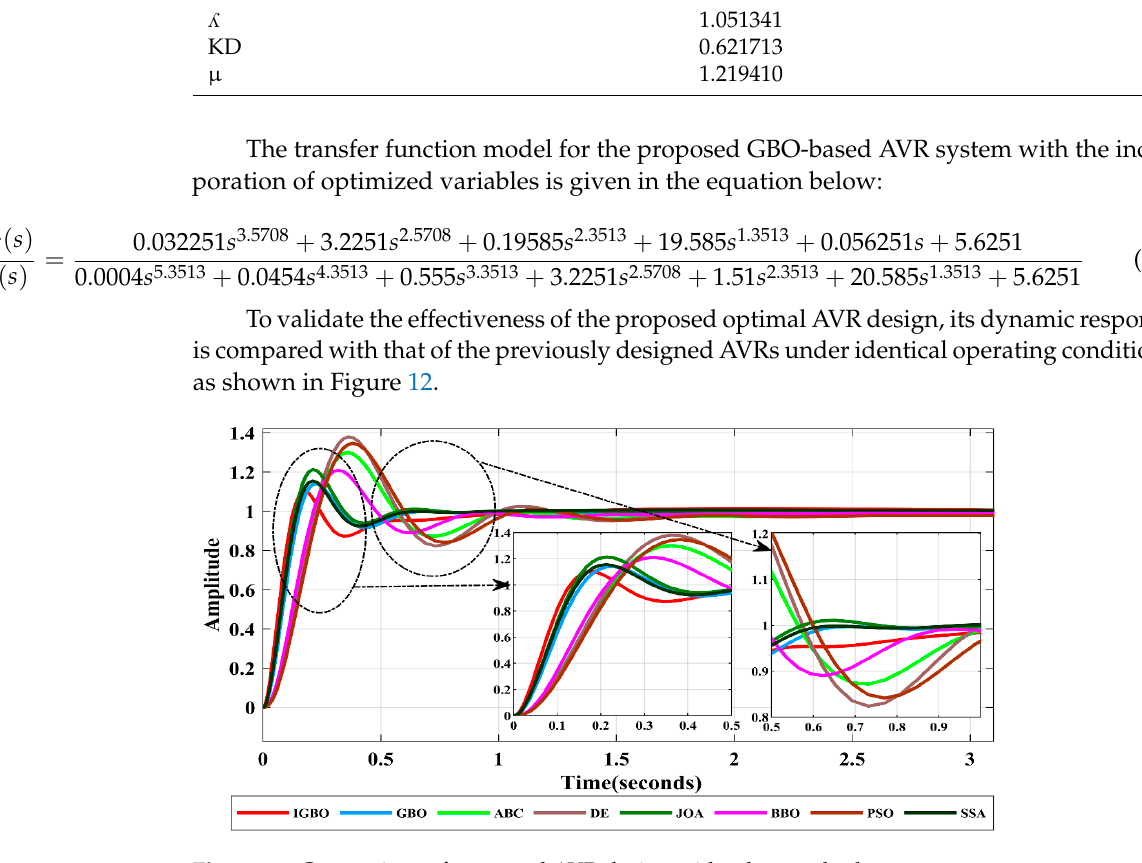
Figure 12. Comparison of proposed AVR design with other methods.